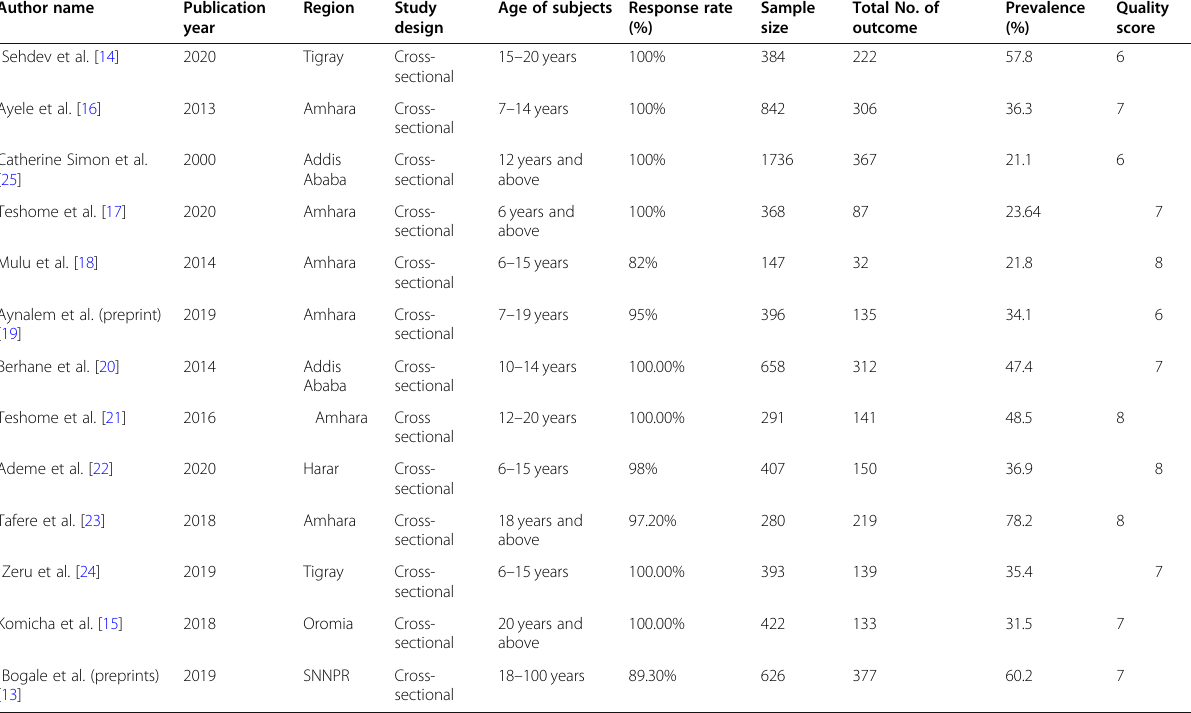
Table 1 Brief summary of incorporated studies assessing the prevalence of dental caries in Ethiopia, 2020